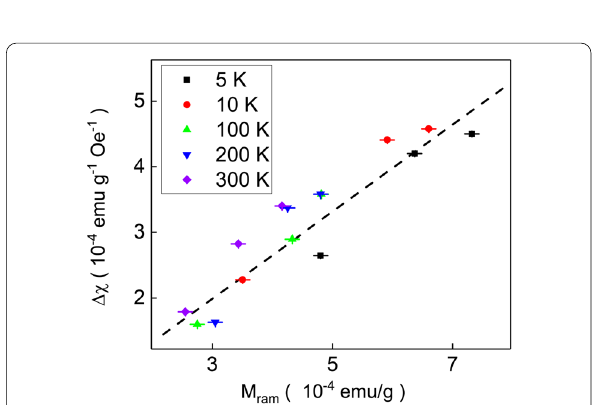
Fig. 7 The paramagnetic‑like susceptibility peak height as a function of remanent magnetization of hysteresis loops in the WSe 2 − x Te x single crystals at different temperatures. The susceptibility peak height is proportional to the remanent magnetization of hysteresis loops. This supports that the observed weakly temperature‑dependent paramagnetic‑like susceptibility peak originates from intrinsic